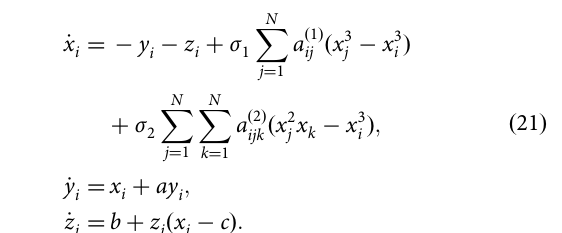
x ; 0 (cid:3) T , e h ð 1 Þ ð x k j x (cid:3) T , h h ð 1 Þ ð x k j